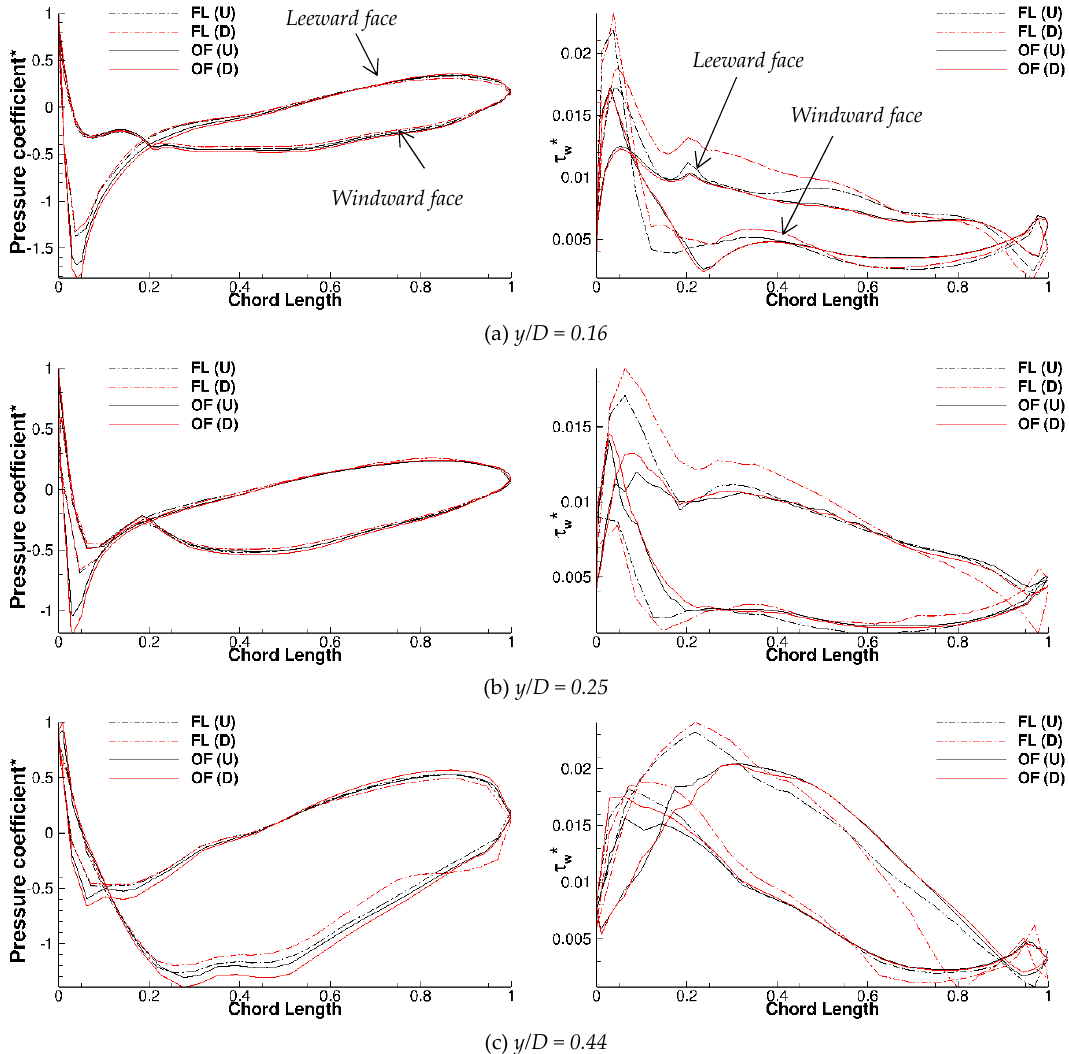
Figure 6. Profile of blade surface pressure coefficient (left panel) and shear stress magnitude distribution (right panel) on windward and leeward faces obtained using Fluent and OpenFOAM unsteady Reynolds averaged Navier-Stokes (URANS) and improved delayed detached eddy simulation (IDDES) at ( a ) y/D = 0.16, ( b ) y/D = 0.25, and ( c ) y/D = 0.44. The coefficients are normalized by relative velocity. The abscissa is normalized by chord length at respective y/D . The y/D locations are shown in Figure 5.